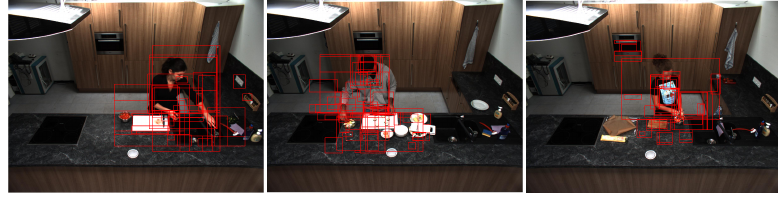
Figure 5. Results of object proposal extraction of our algorithm and Selective Search. The red boxes represent the object proposals. The action categories of these three groups of images are “wash hands”, “put in bowl”, and